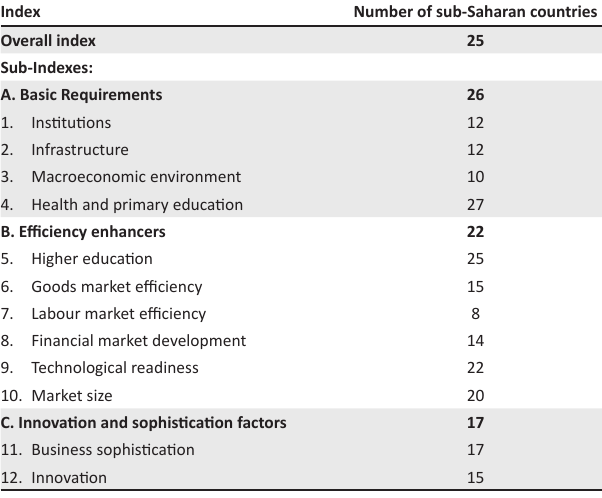
TABLE 2: Number of sub-Saharan countries among the lowest 25 %